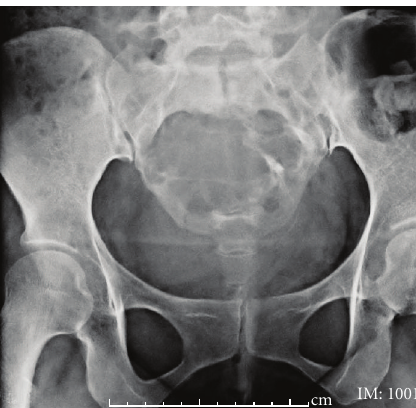
Figure 6: Plain radiograph, 1 year post operative shows sclerosis of bony destruction at sacrum. MR examination of pelvis one year after surgery demonstrates no significant change in size and aggressiveness of the tumor, but not